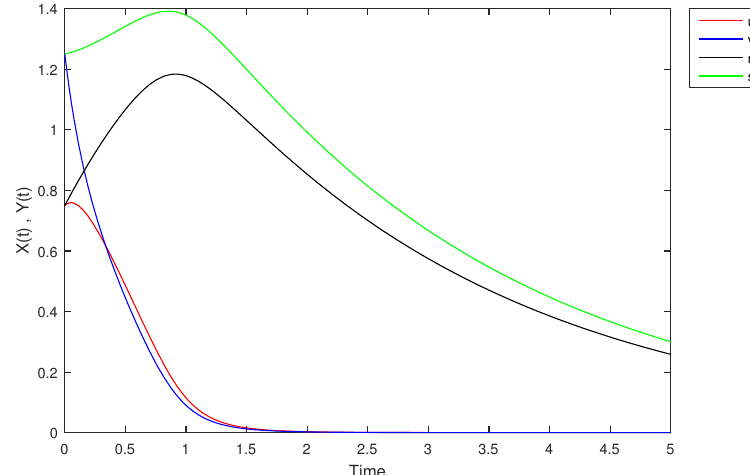
Figure 12. The solution of (7) at α = 0.5 for short time period.